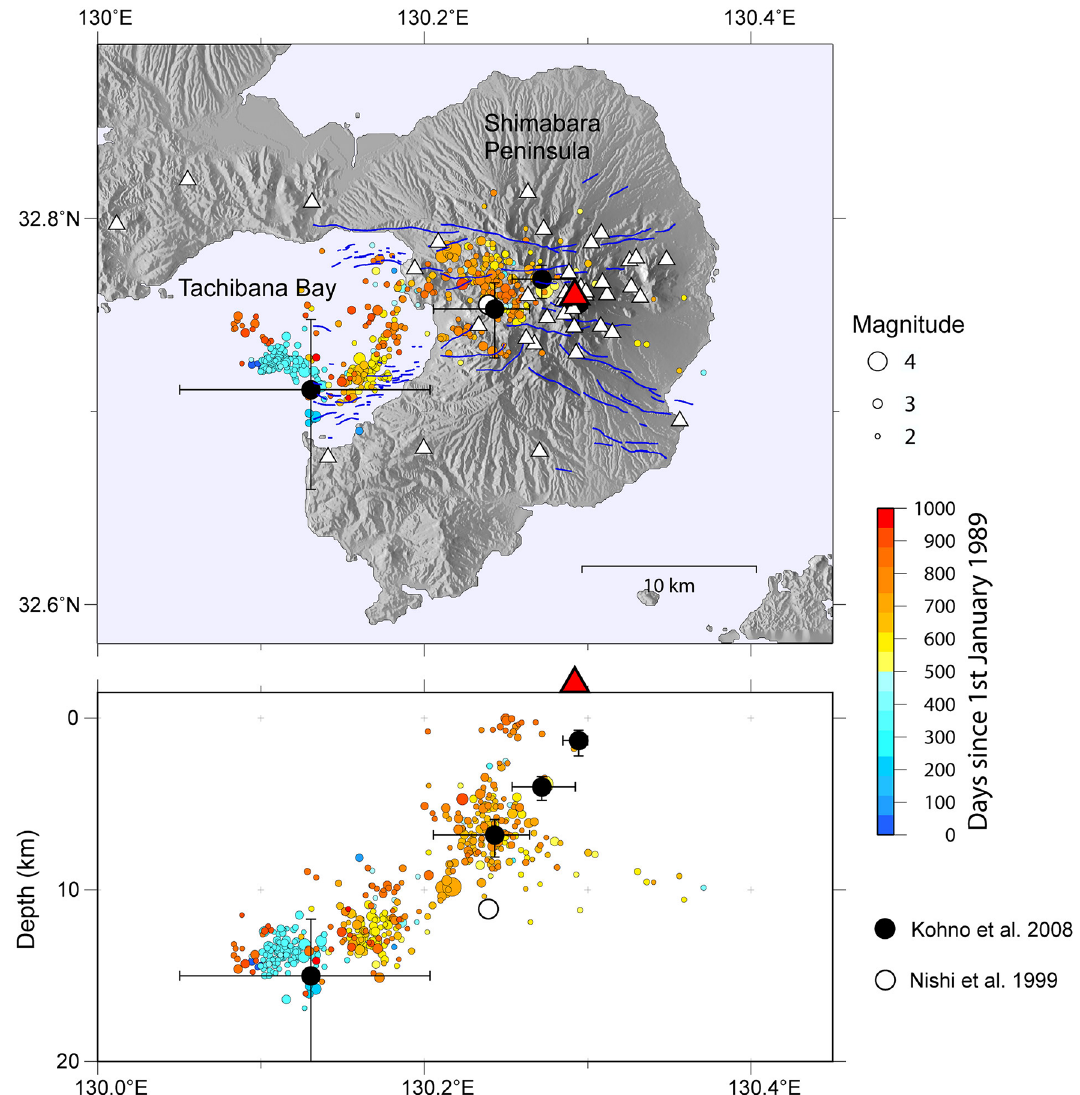
Figure 1. Hypocenter distribution for the 1000 days since 1 January 1989, taken from Umakoshi et al. (2001). The first eruption occurred on 17 November 1990. White triangles indicate seismic stations used in this study. Note additional seismic stations were used in this study that lie outside the region shown above (see Fig. 2a). Red triangle and blue lines indicate Mt. Fugendake and active faults (Tsutsumi, 2015), respectively. Solid circles and lines show the pressure sources and 1σ error bars determined by joint leveling and GPS observations (Kohno et al., 2008). White circle indicates the pressure source determined by GPS observations (Nishi et al.,